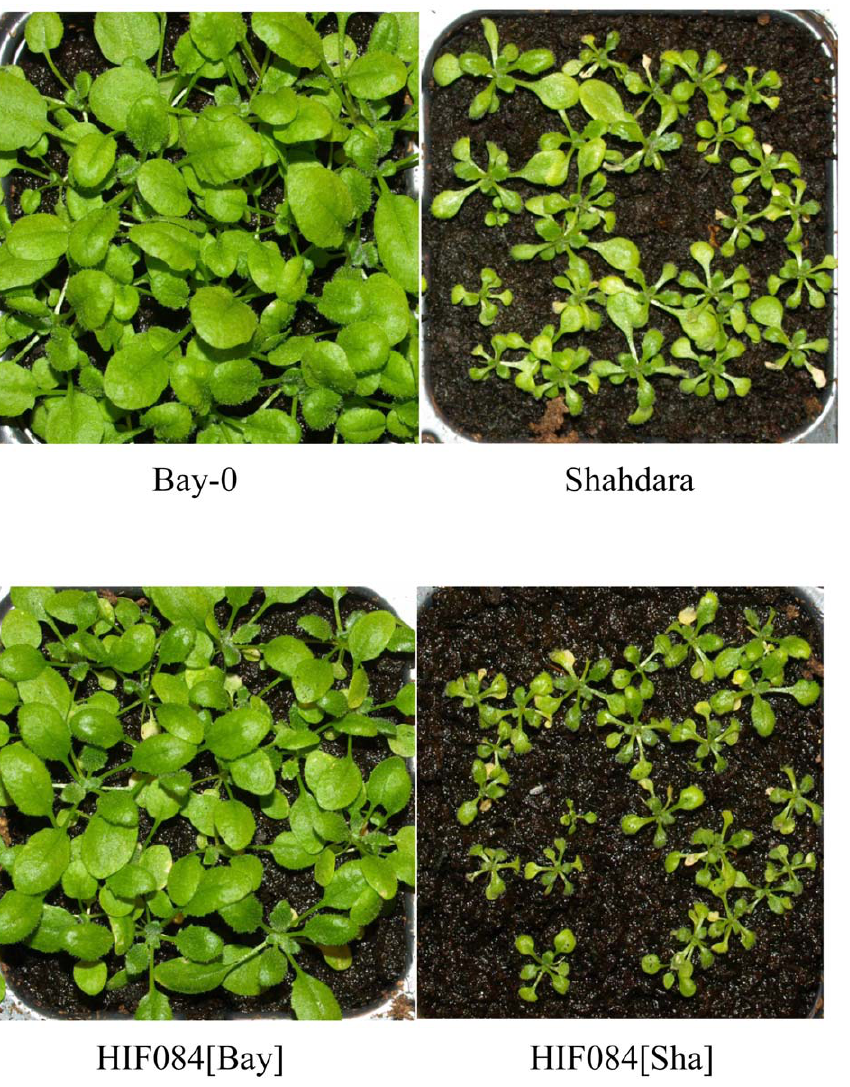
Figure 1. Acidic peatmoss substrate induces severe growth defect linked to the Shahdara allele. When grown on peatmoss at a pH close to 5, Shahdara is subject to severe growth and developmental arrest, necrosis and death, contrary to Bay-0 which develops normally. In the cross between these two strains, this phenotype is entirely controlled by a single locus (Figure S1), as confirmed by near-isogenic line ‘HIF084’ segregating solely for a region of chromosome